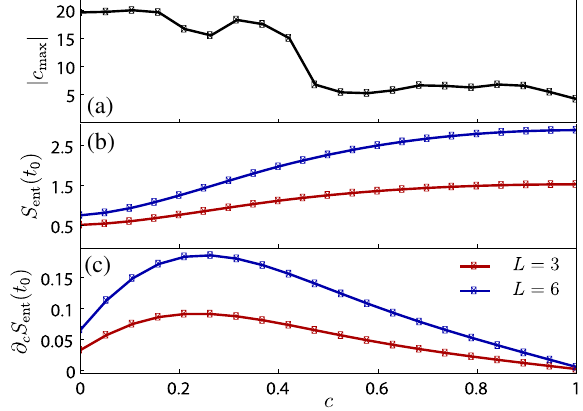
FIG. 3. (a) A rapid drop in the largest component of the Fourier spectrum of a local observable, n 1 ð t Þ , signals the onset of chaotic behavior. (b) The entropy of a region of size L at fixed time t 0 ¼ 15 remains low when the quantum dynamics is launched near the center of the regular region (we use the iTEBD algorithm to simulate quantum dynamics). When the border of the regular region is approached, the value of entanglement rapidly increases with changing the initial state, defined by the value of c . When c approaches one, the dynamics becomes insensitive to the changes in the initial state due to rapid thermalization. (c) The derivative of entropy along the trajectory is most sensitive around the boundary of the regular